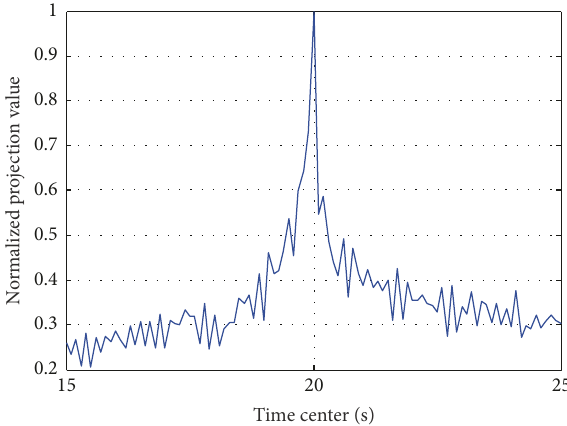
Figure 7: Curve of outlier data feature state response distribution detected with dynamic scheduling of information flows (the pro- posed method).